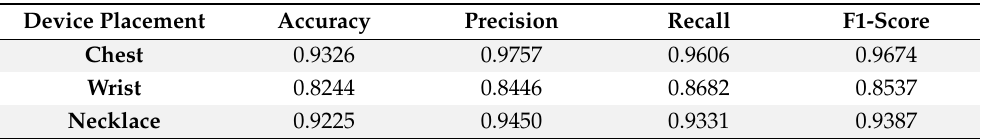
Table 2. Comparison of average accuracy, average precision, average recall, and average F1-score of models trained on chest, wrist, and necklace data and tested using chest, wrist, and necklace dataset collected from young adults.